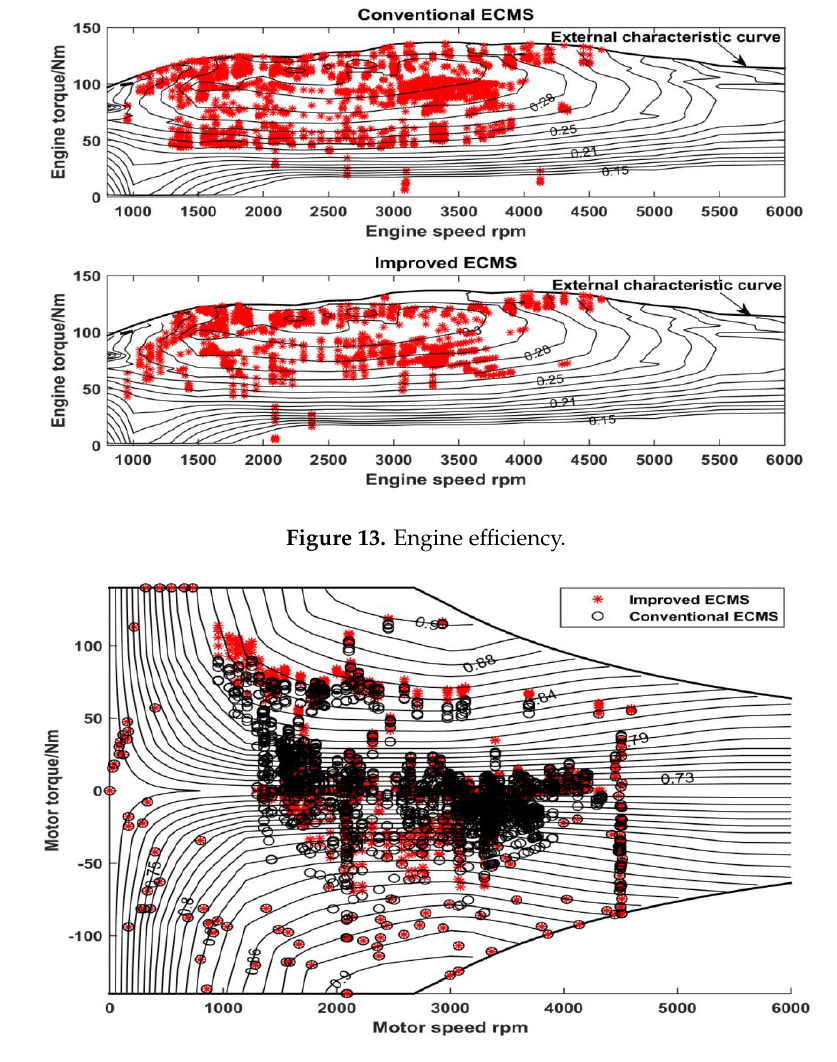
ffi Figure 14. Motor efficiency. Figure 14. Motor e Figure 14. Motor efficiency.